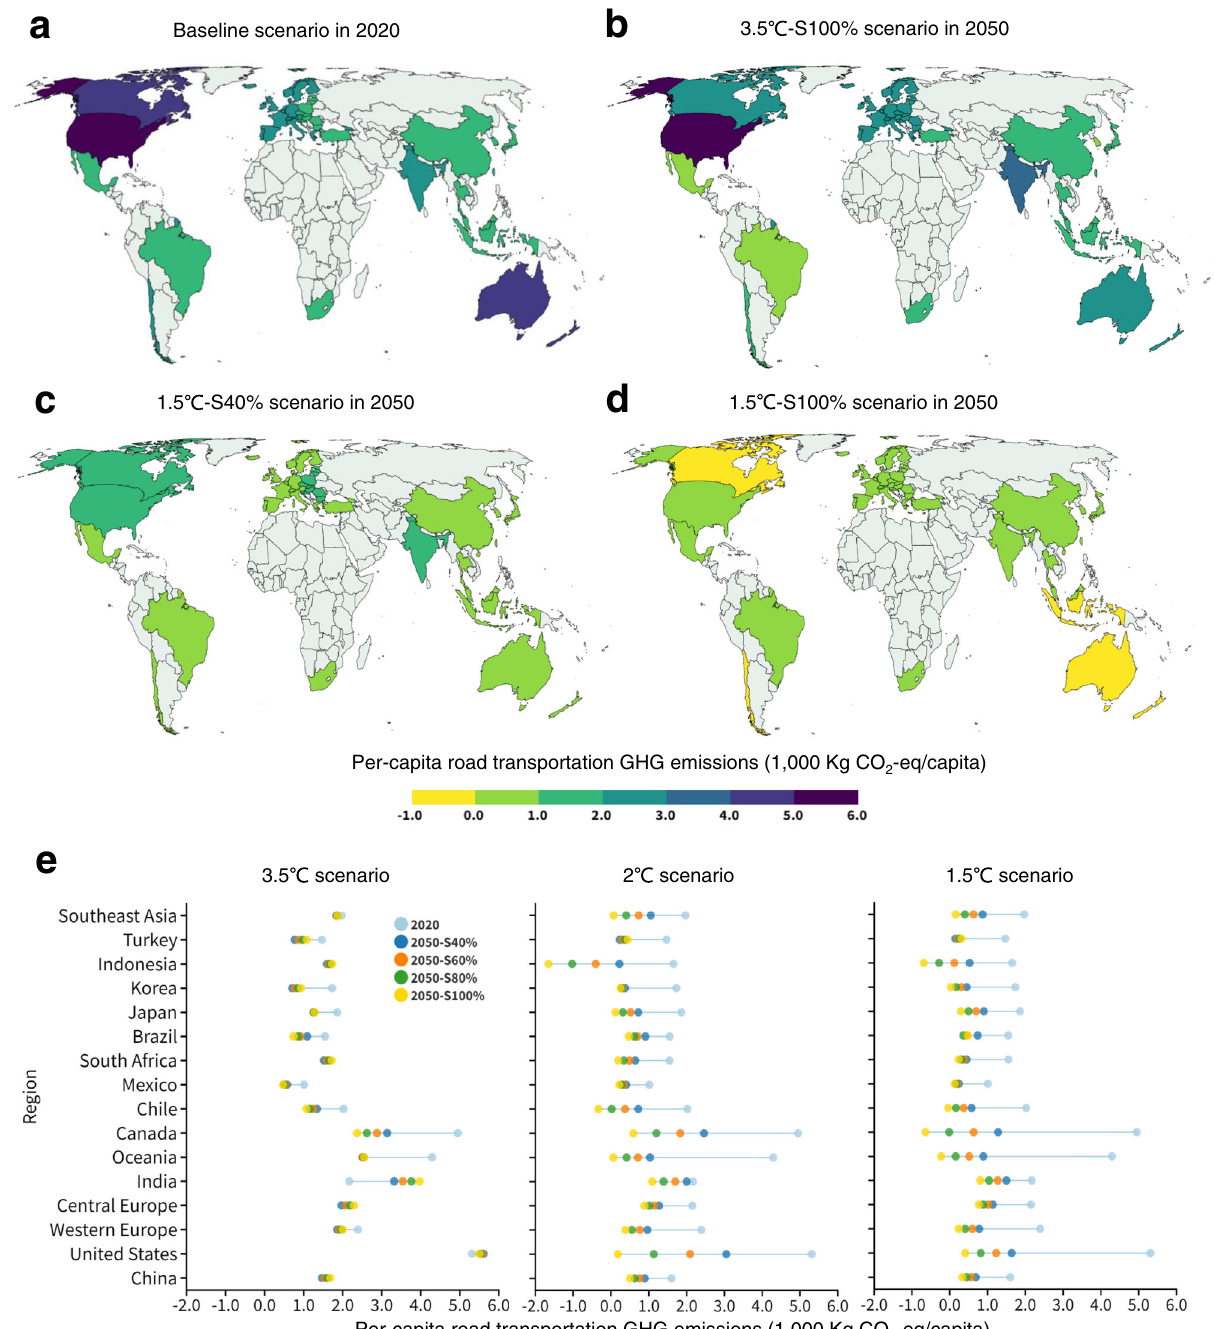
Fig.5|Per-capitagreenhousegas(GHG)emissionsfromroadtransportationin 16 regions. a – d Per-capita GHG emissions from road transportation under the a baselinescenarioin2020, b 3.5°C-S100%scenarioin2050, c 1.5°C-S40%scenario